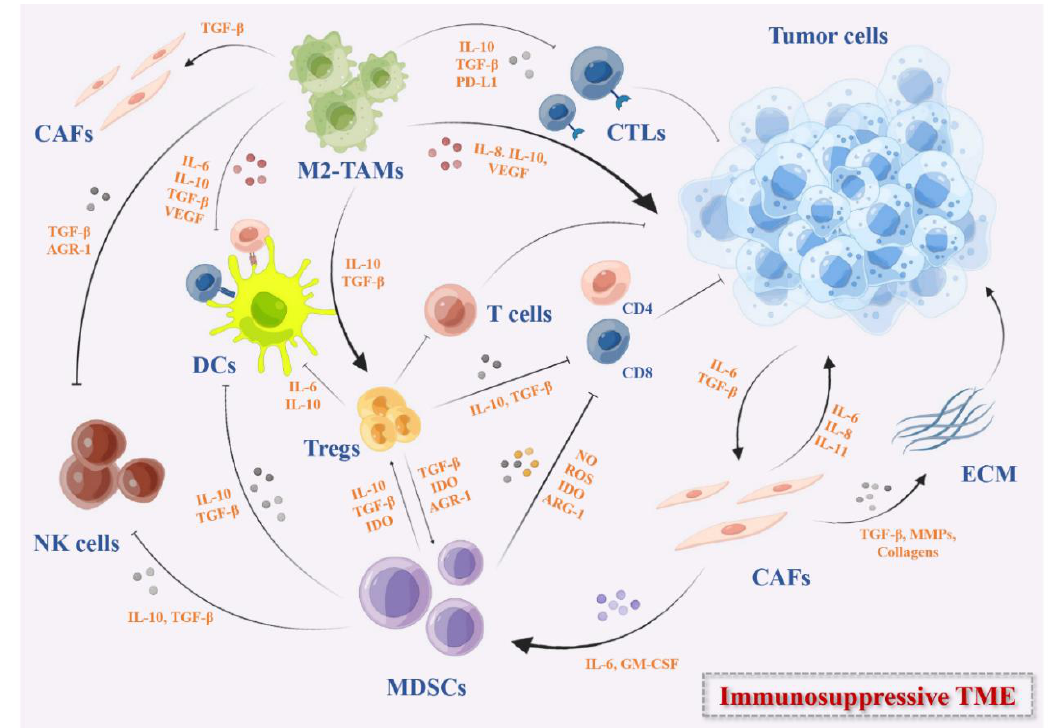
Figure 1. The immunosuppressive TME in solid tumors. These immunosuppressive cells include MDSCs, DCs, M2-TAMs, Tregs, and CAFs. They secrete immunosuppressive cytokines such as IL-10, IDO, TGF- β, growth factors such as VEGF, the checkpoints ligands such as PD-L1, or express checkpoints on the cell surface that can inhibit the activation of DC-mediated T cells and effector T cells directly or indirectly, remodel the ECM, and promote the angiogenesis in TME.